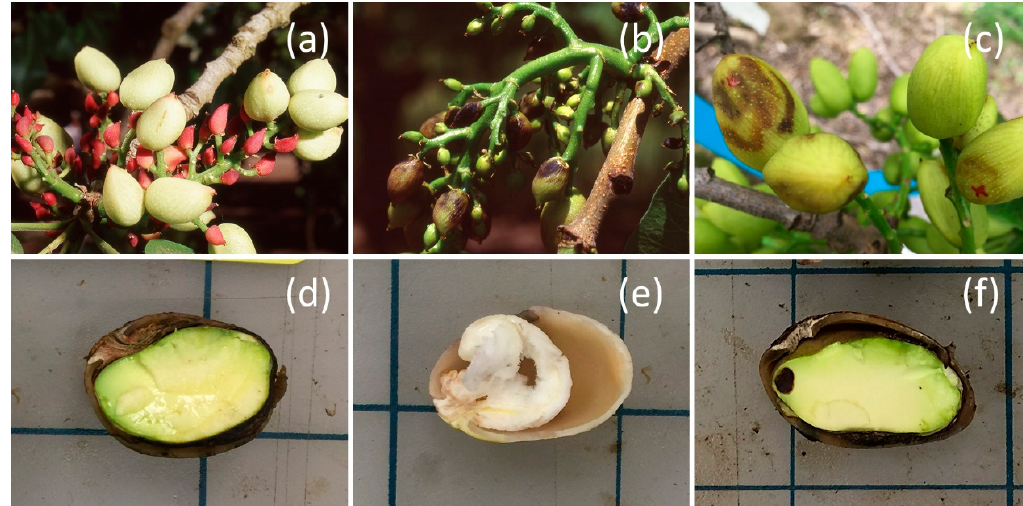
Figure 1. Pistachio clusters naturally drop nuts during fruit set ( a ), but heteropteran feeding can cause small nuts to blacken and drop ( b ) and larger nuts to form epicarp lesions ( b , c ); near harvest time, compared with an undamaged nut ( d ), heteropteran feeding can result in aborted nuts or blanks ( e ) and direct nut damage or kernel necrosis ( f ). Photos: Stahl and Daane.